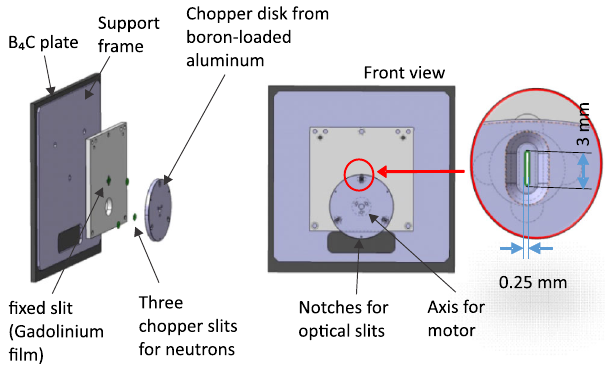
FIG. 3. The beam chopper, composed of a rotating disk with 3 slits and one fixed slit. The borated aluminum around the gadolinium slits is beveled giving a sufficient aperture angle for the beam when the disk is rotating. Diametrically opposed of each slit is an optical slit at large radius to activate an optical switch. Neutrons cannot pass the optical